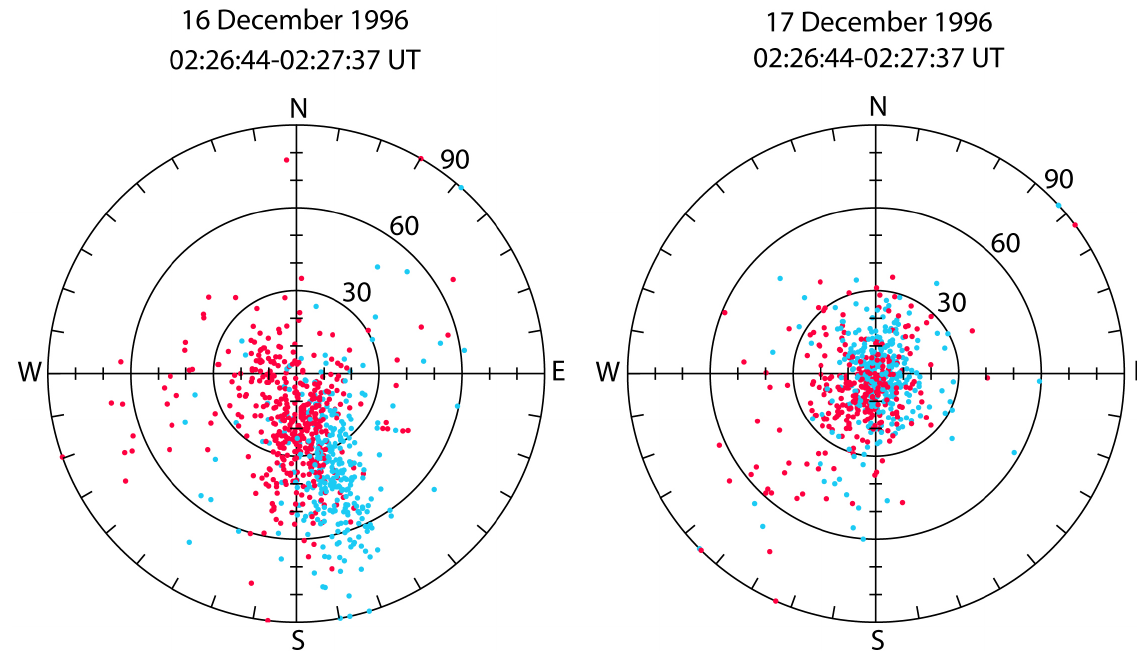
Fig. 9. Comparison between echo-location maps derived from E-region drift measurements performed on 16 and 17 December 1996 between 02:26 and 02:28 UT (approximately 10:30 LT at Casey). Approaching and receding echoes are displayed in blue and red, respectively. All cardinal directions are expressed in a compass oriented coordinate system. Concentric circles indicate zenith angles separated by 30 ◦